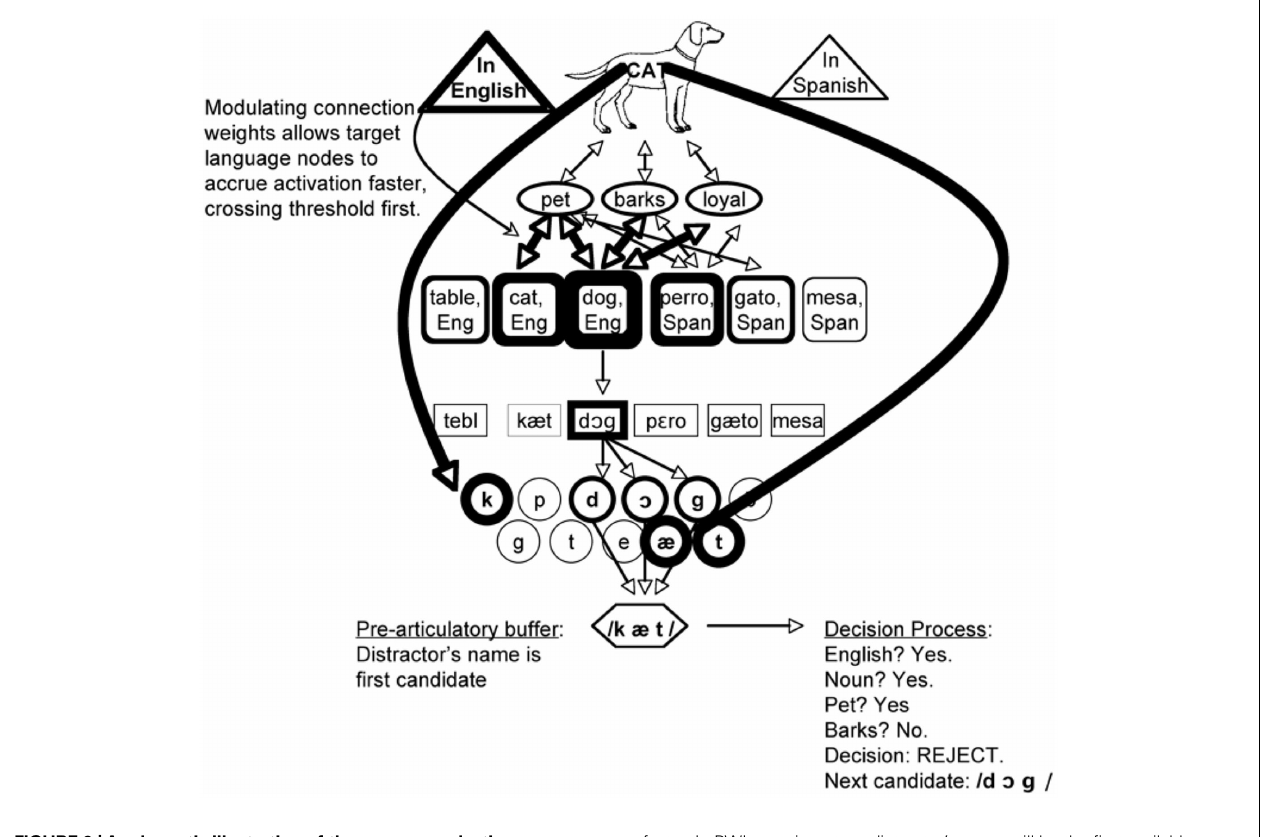
FIGURE 9 |A schematic illustration of the response selection model (Finkbeiner et al., 2006a). Lemma selection is accomplished by a threshold mechanism, rather than by competition.The speaker’s intention to use English allows English lemmas to accrue activation